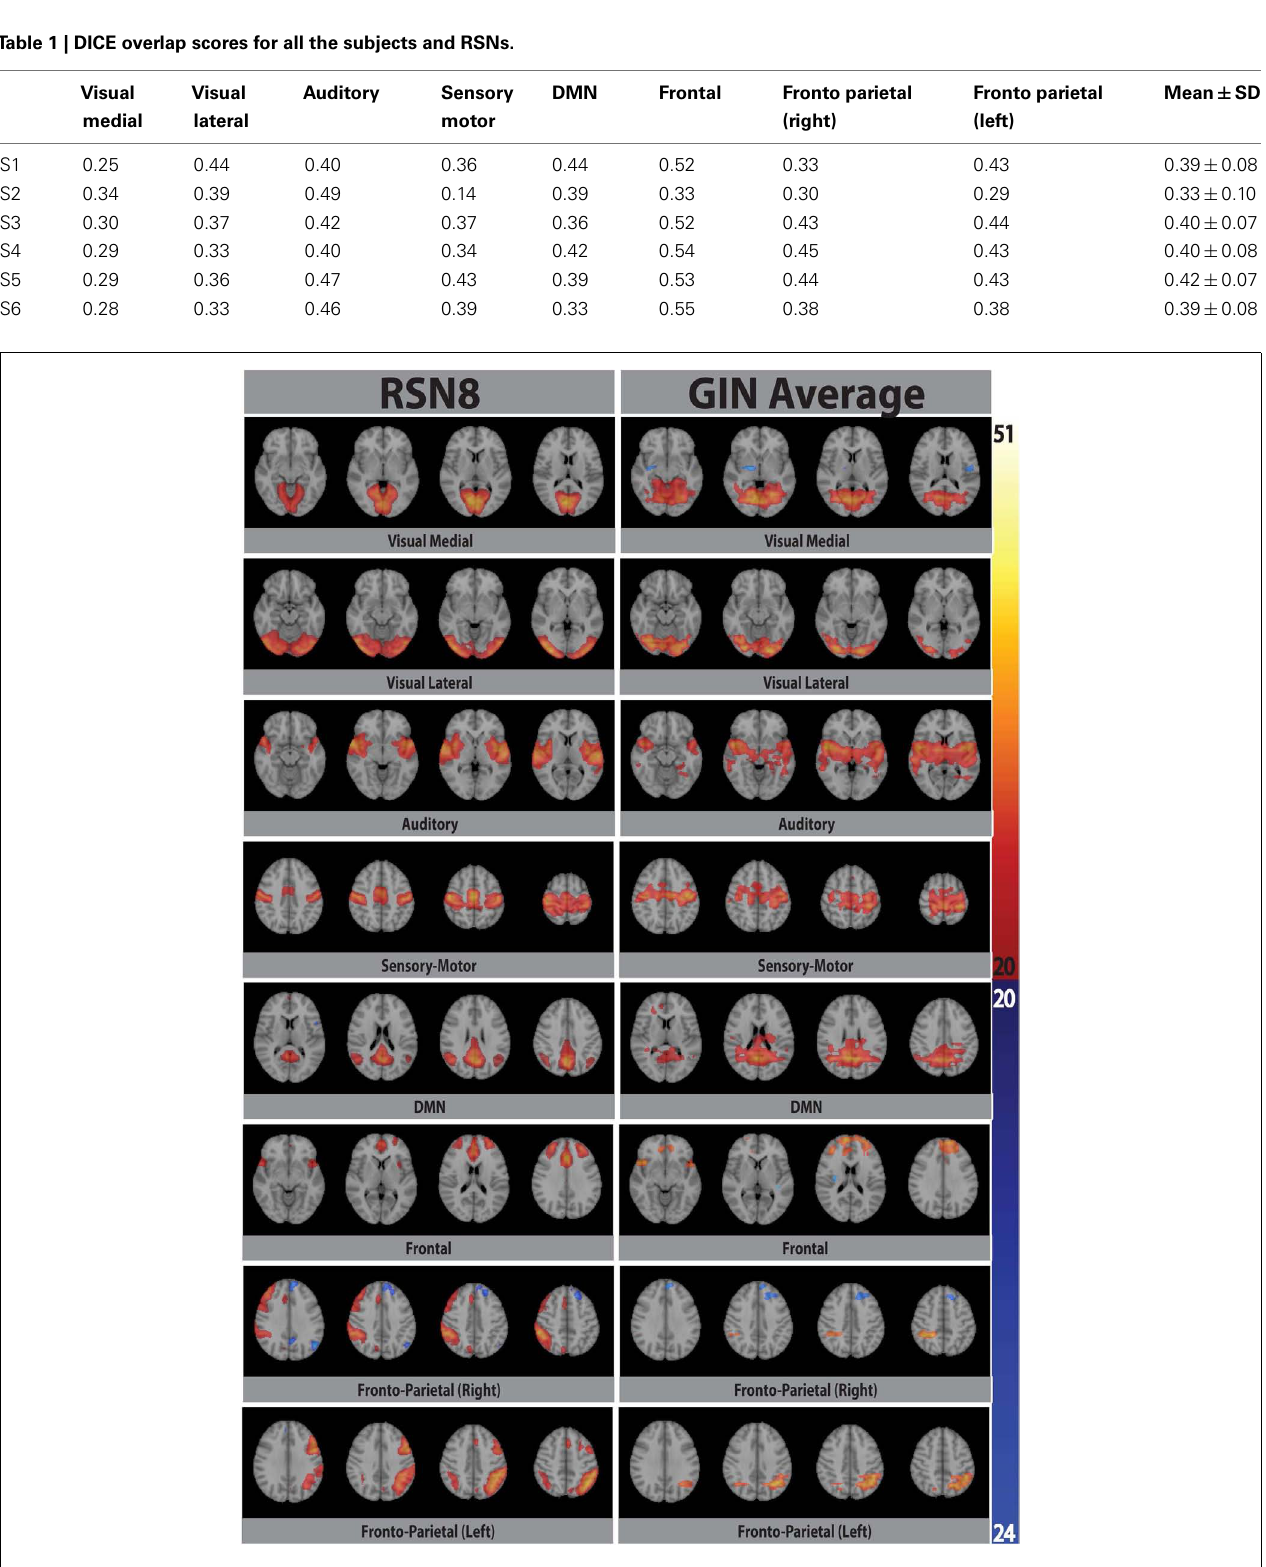
FIGURE 3 | Eight prototypical RSNs (Beckmann et al., 2005) and the corresponding dual regression maps (in z -scores) averaged over all subjects and overlaid on the four most representative slices in MNI space .